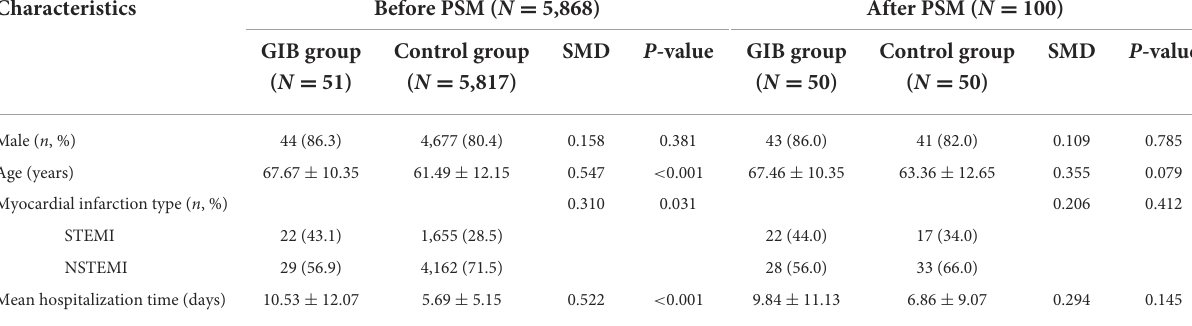
TABLE 1 Clinical characteristics of in-hospital GIB in AMI patients before and after PSM. Characteristics